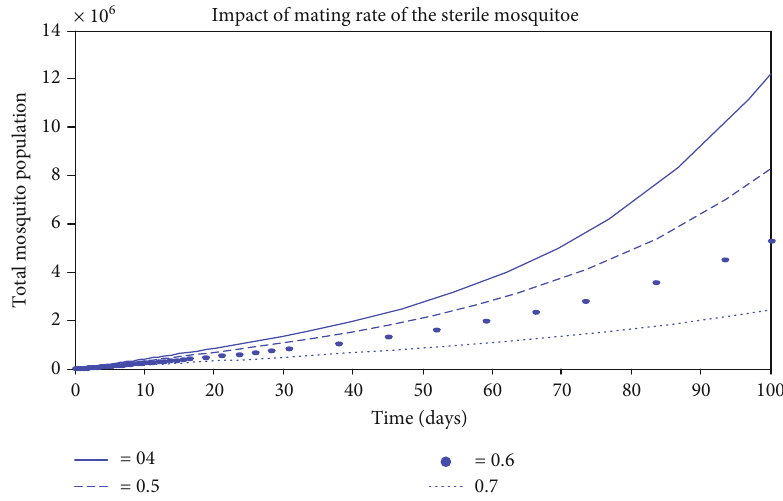
Figure 6: Impact of mating rate ð β Þ of the sterile mosquitoes on the total mosquito population; an increase in this rate also leads to a 2 reduction in the total mosquito population.